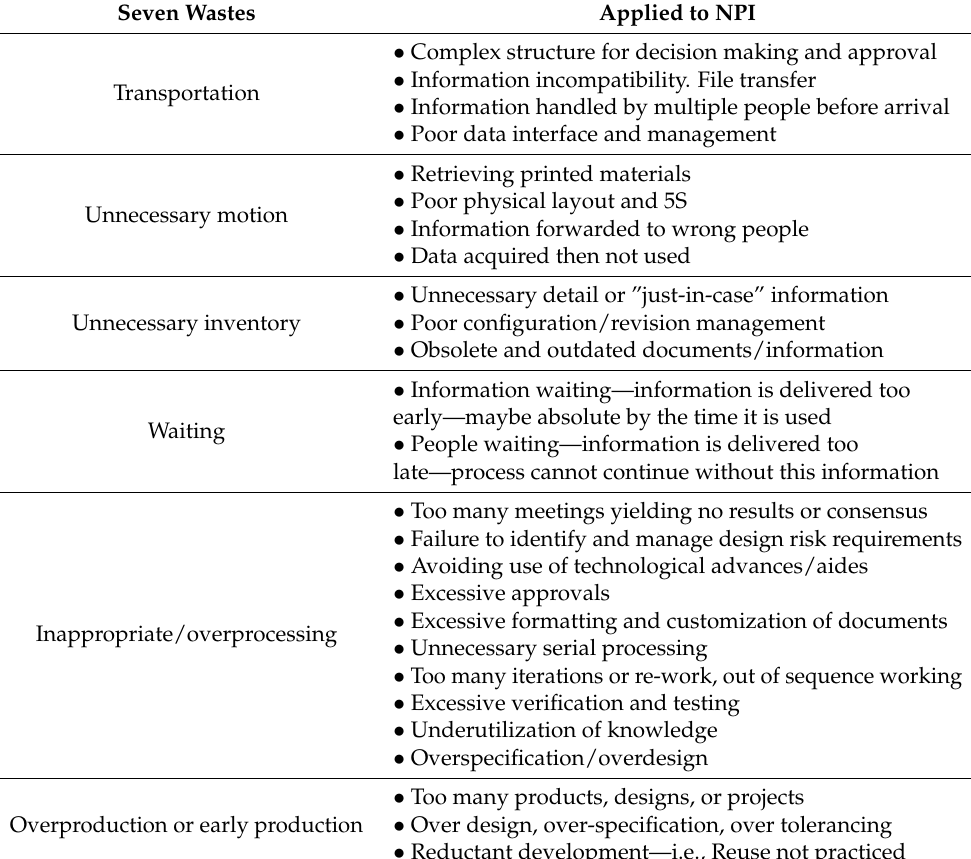
Table 2. Seven wastes and their application to NPI